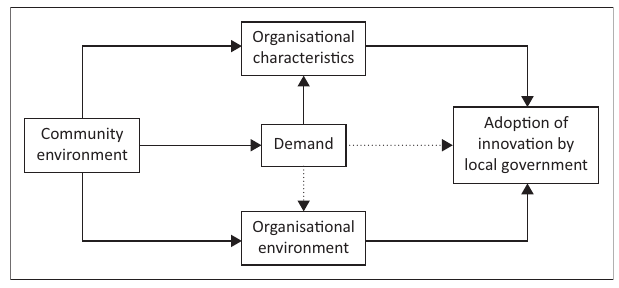
FIGURE 2: A model for the adoption of technological innovation by local